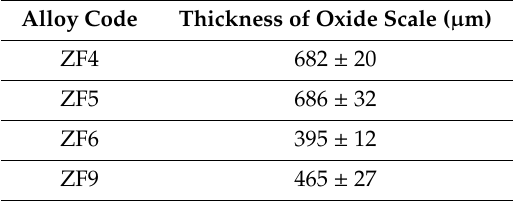
Table 8. The thickness of the spalled oxide scales formed on the oxidised alloys after exposure for 100 h at 1200 °C.